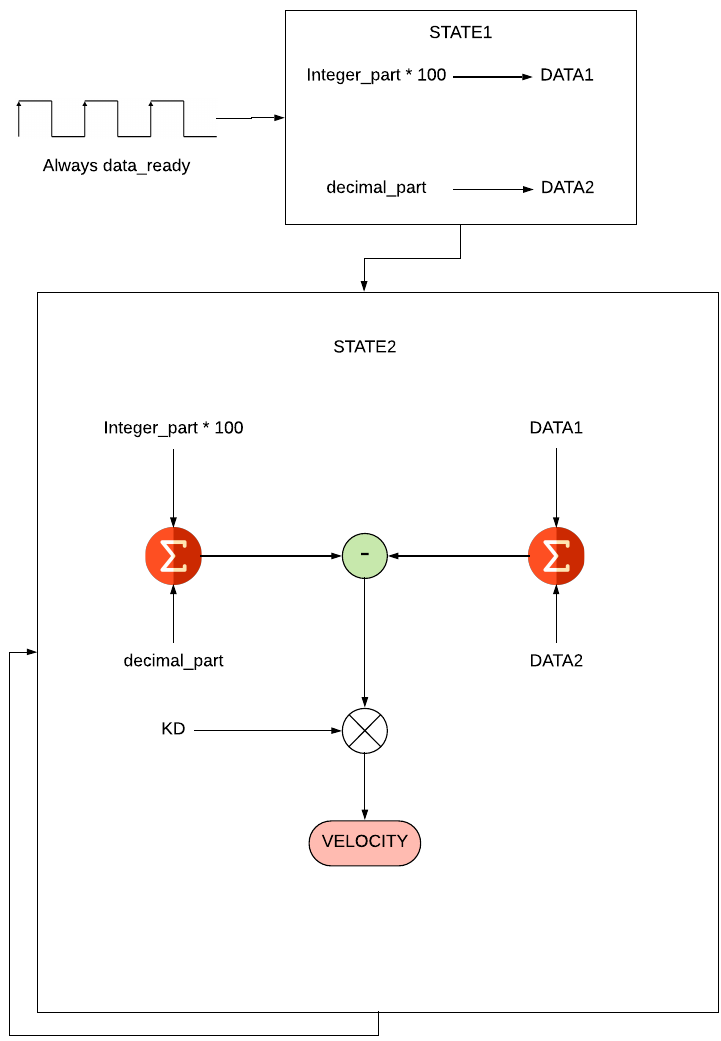
Figure 11. Flow diagram of D